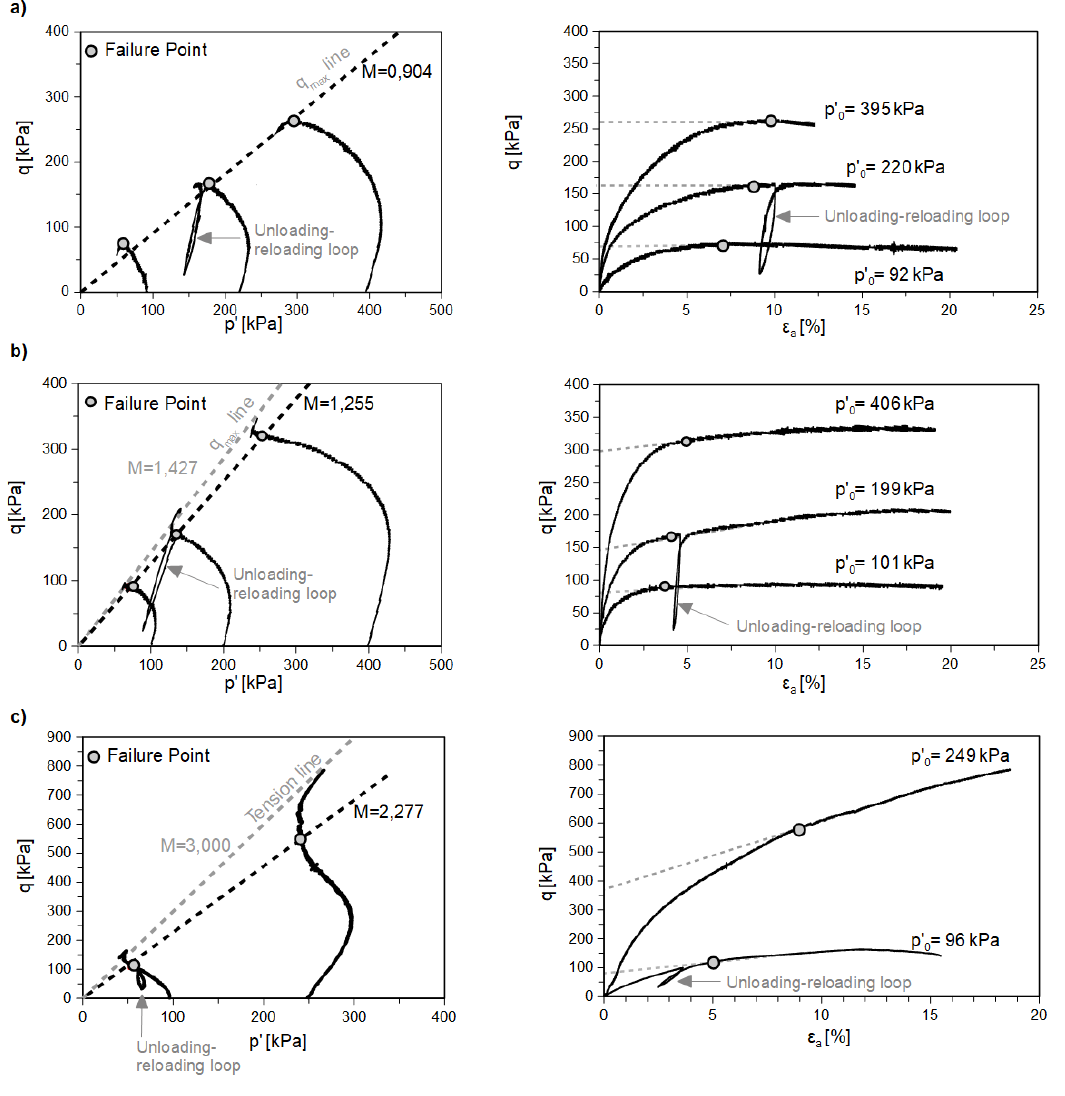
Figure 3: The CU tests results for (a) organic silty clay, (b) organic silt and (c)